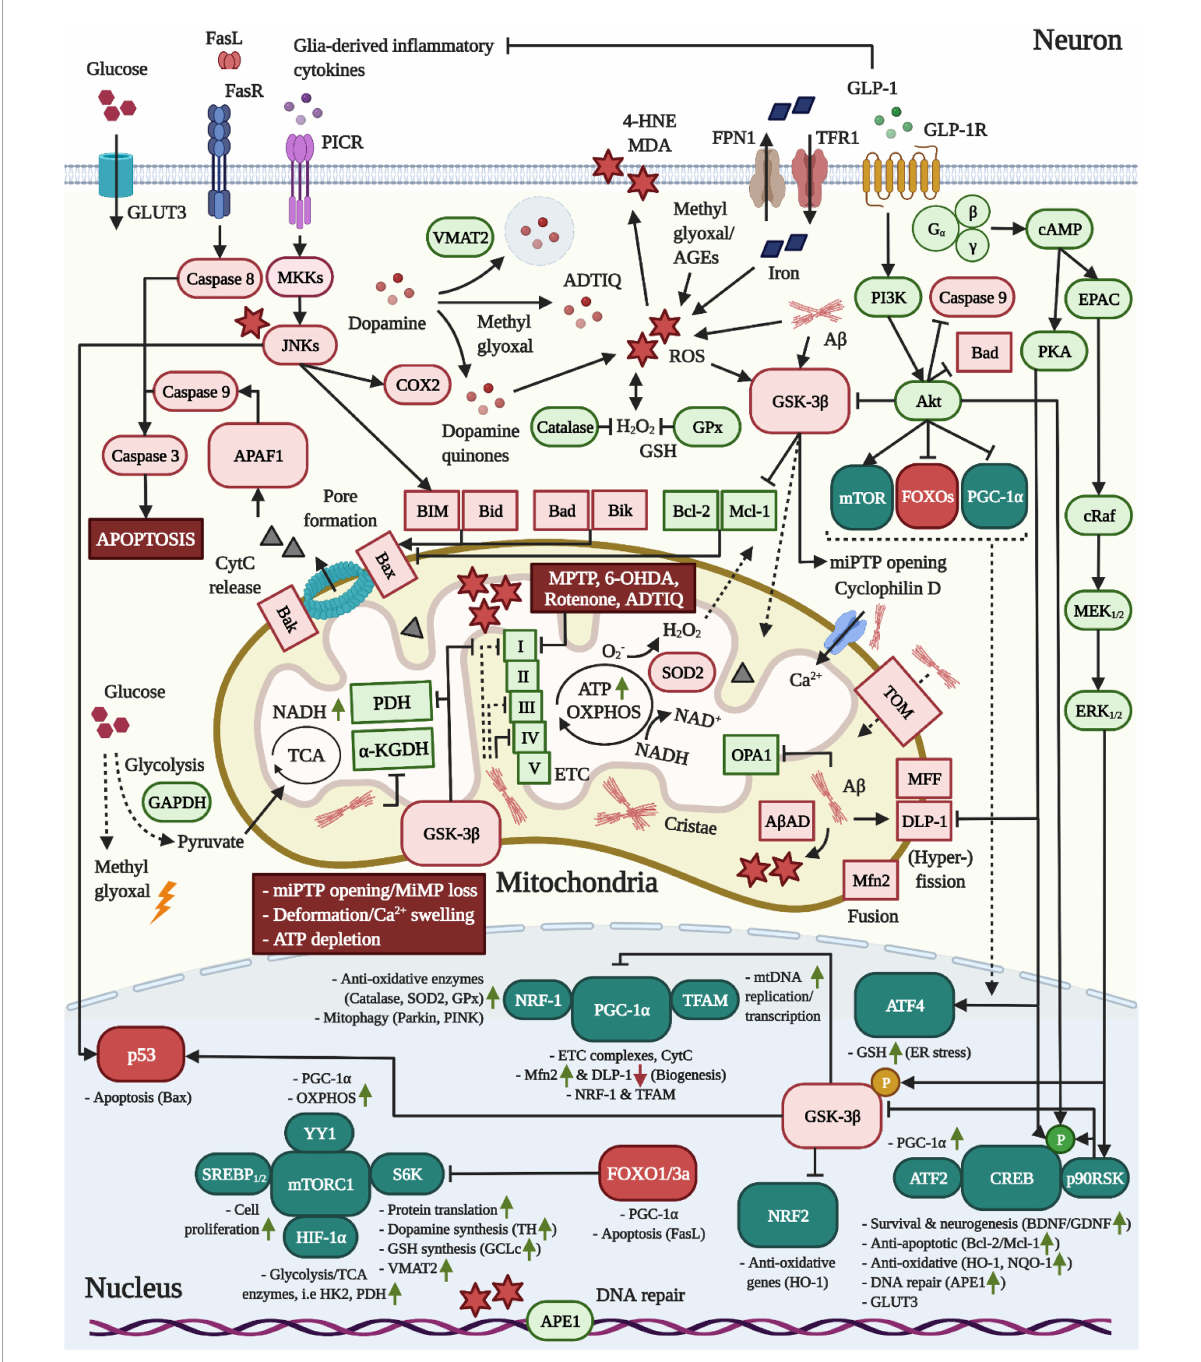
FIGURE2 Pro-mitochondrial, anti-oxidative and anti-apoptotic effects of GLP-1 in neurons. 1 In AD, A β is translocated into mitochondria via TOM and accumulates in cristae, leading to elevated ROS production through the interaction with A β AD and the impairment of the TCA enzymes PDH/ α -KGDH as well as complex VI, but also I and II, of the ETC. Moreover, A β triggers mitochondrial Ca 2 + instream and swelling by binding to cyclophilin D and stimulates mitochondrial fragmentation by altering the expression of fusion/fission-modulating proteins. 2 As common for both neurodegenerative diseases, pro-inflammatory cytokine signaling across PICRs stimulates JNK to activate BIM and Bax-expression via p53. While dopamine is packaged into synaptic vesicles by VMAT2 in dopaminergic neurons, JNK may induce COX2 to encourage the production of reactive dopamine quinones. Pathologic alterations in the expression and localization of GAPDH as well as insulin resistance-associated